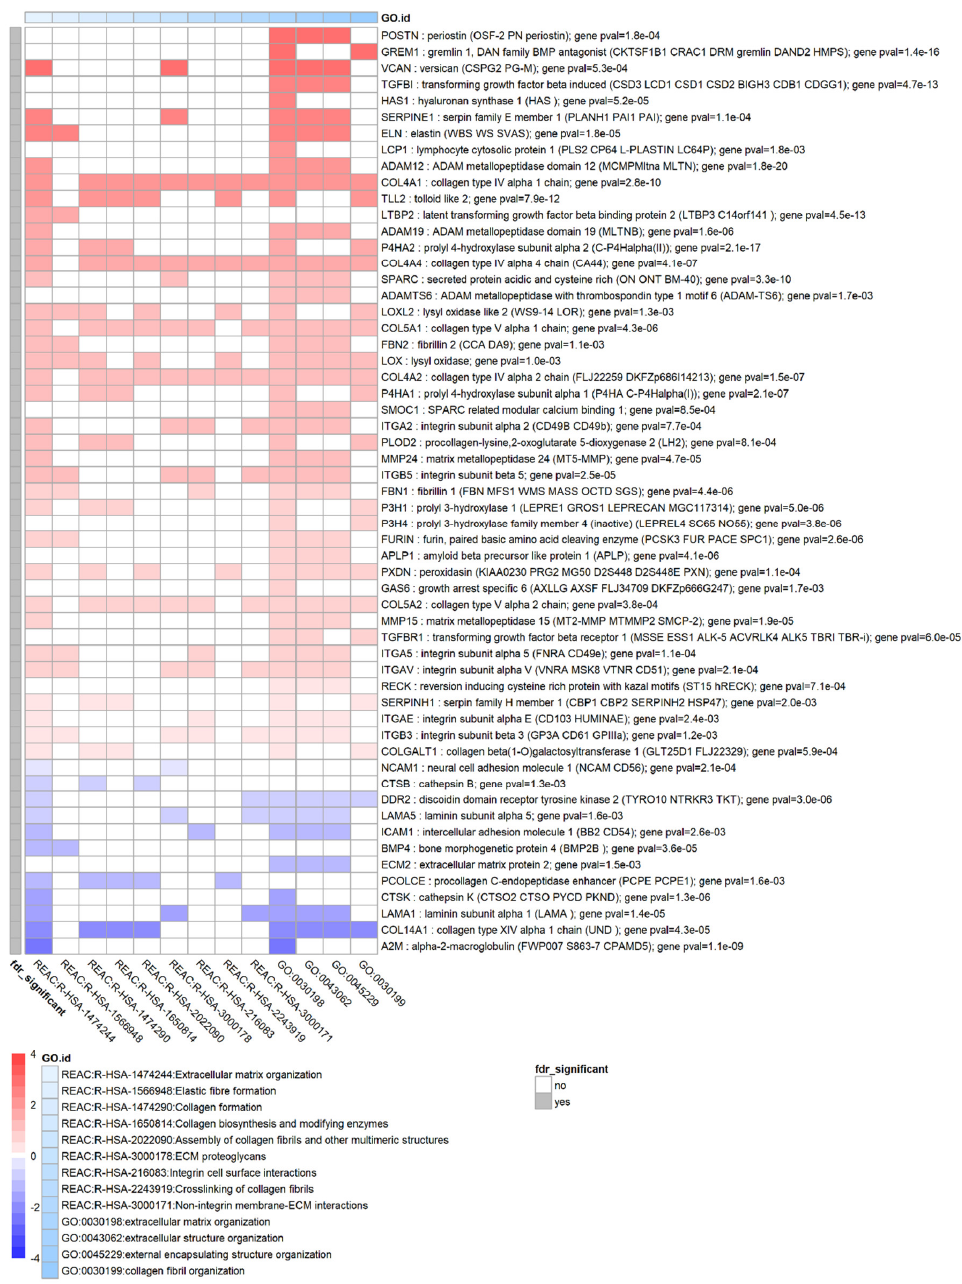
Figure 5. Genes and enrichment terms associated with the cluster ‘ECM remodelling’. Heatmap showing the genes with false discovery rate FDR < 0.05 for genes associated with extracellular matrix remodelling enrichment terms. Heatmap colours correspond to fold change expressed as log 2 FC which has been limited to a range of [-4, 4] for clarity. The grey annotation bar on the left shows if the false discovery rate FDR < 0.05 (in which FDR is the BH corrected p -value) for a particular gene which is the case for all genes considered here. To enable visualisation of this cluster, a subset of all enrichment terms in this cluster is shown.